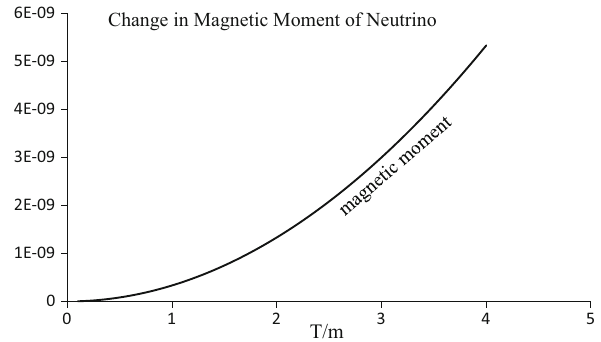
Fig. 4 The ratio of (thermal) electrons background corrections to the magnetic moment of the electronic type neutrino with the correspond- ing vacuum value of the magnetic moment is plotted as a function of temperature below the neutrino decoupling temperature to extract the